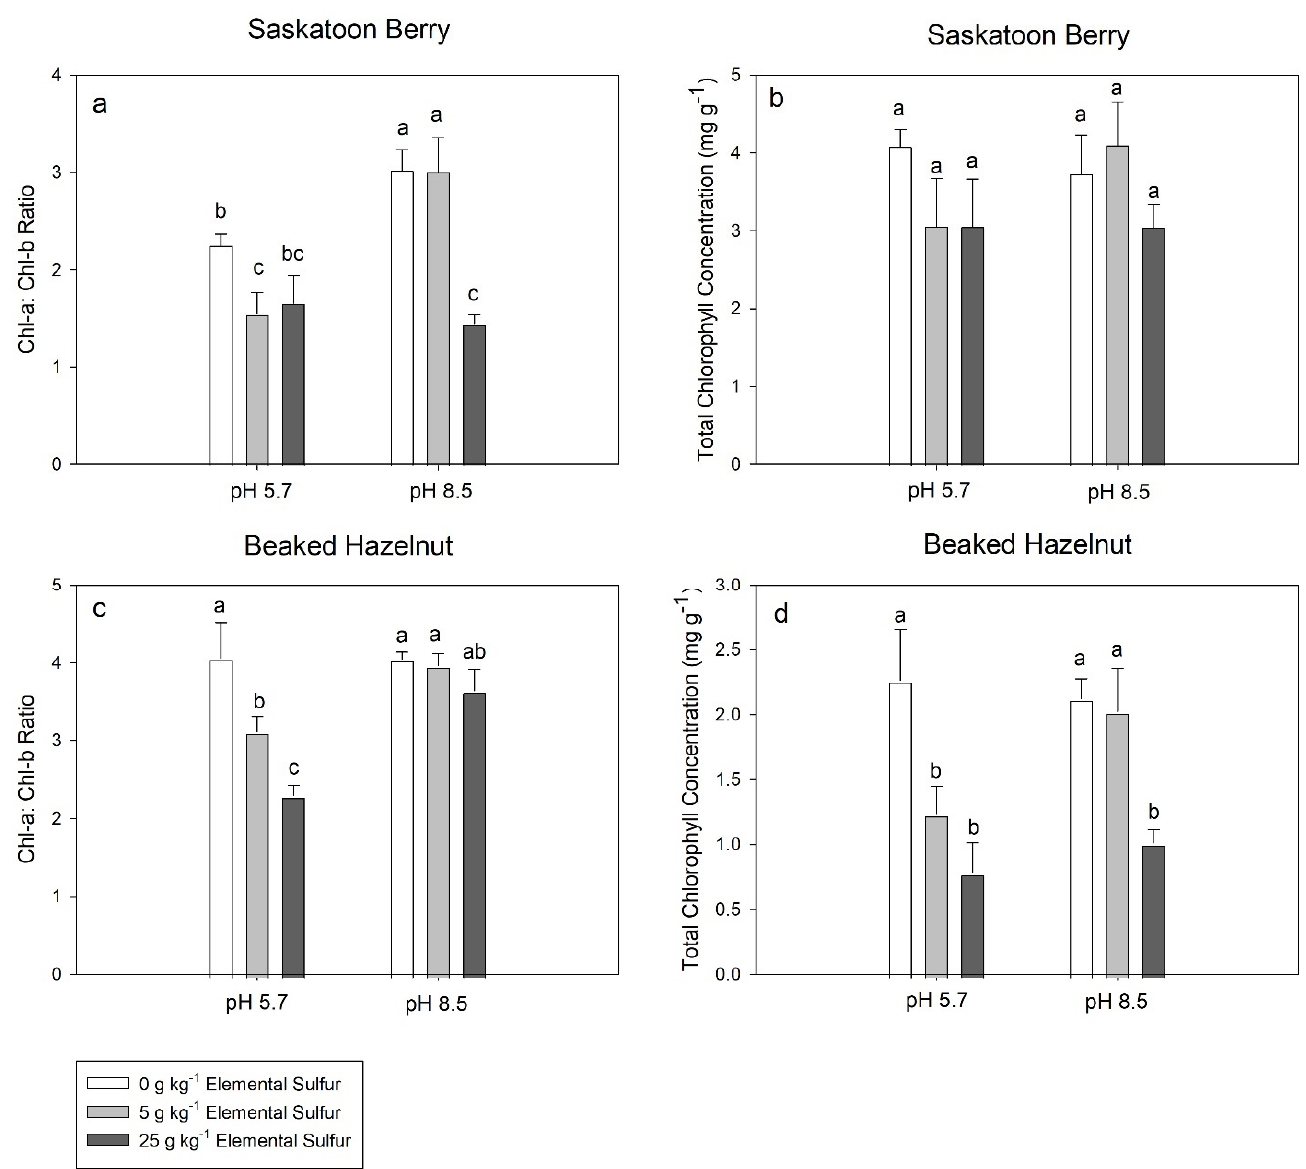
Figure 2. Leaf chlorophyll-a and chlorophyll-b concentrations in Saskatoon berry ( a , b ) and beaked